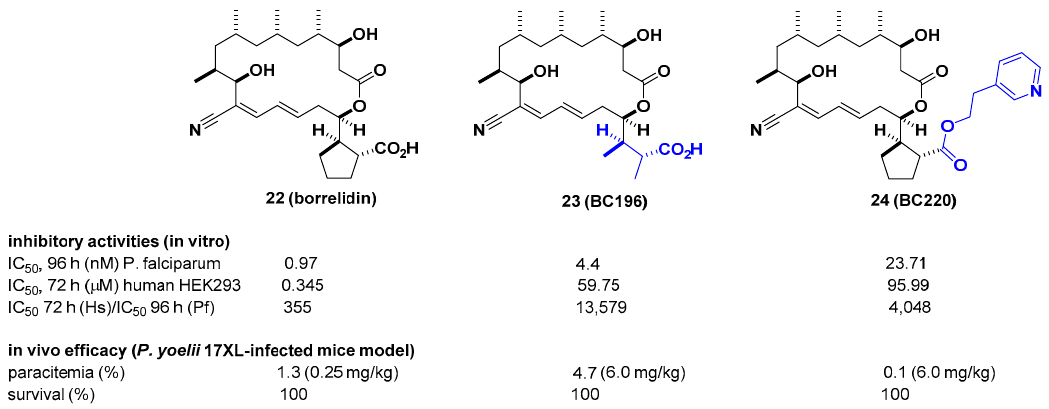
Figure 8. Optimization of borrelidin selectivity for Plasmodium falciparum over human threonyl-tRNA synthetase (ThrRS).